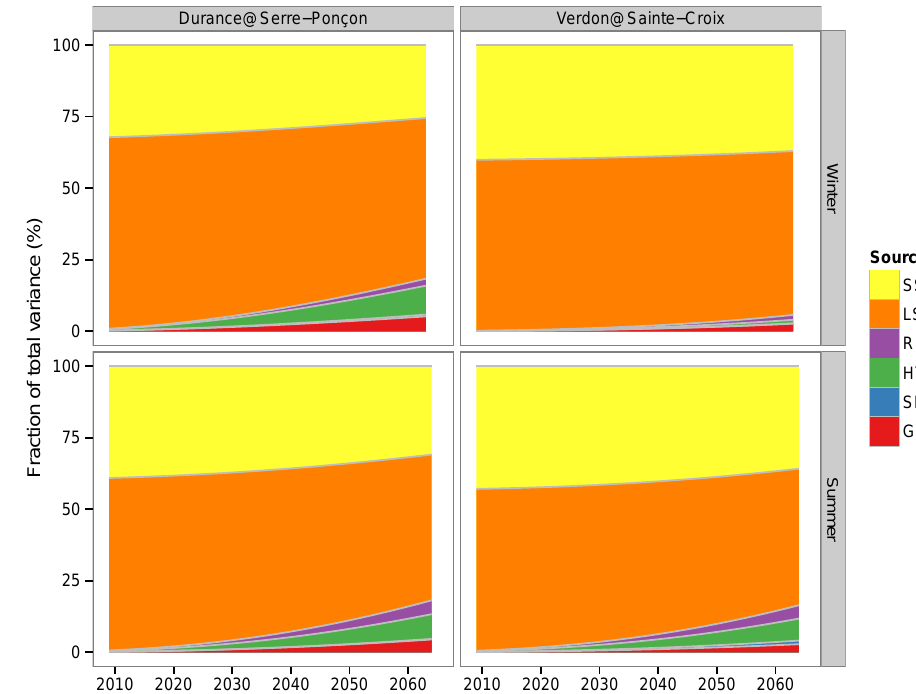
Figure 8. As for Fig. 7, but for yearly low-flow anomaly with respect to the REF period average.